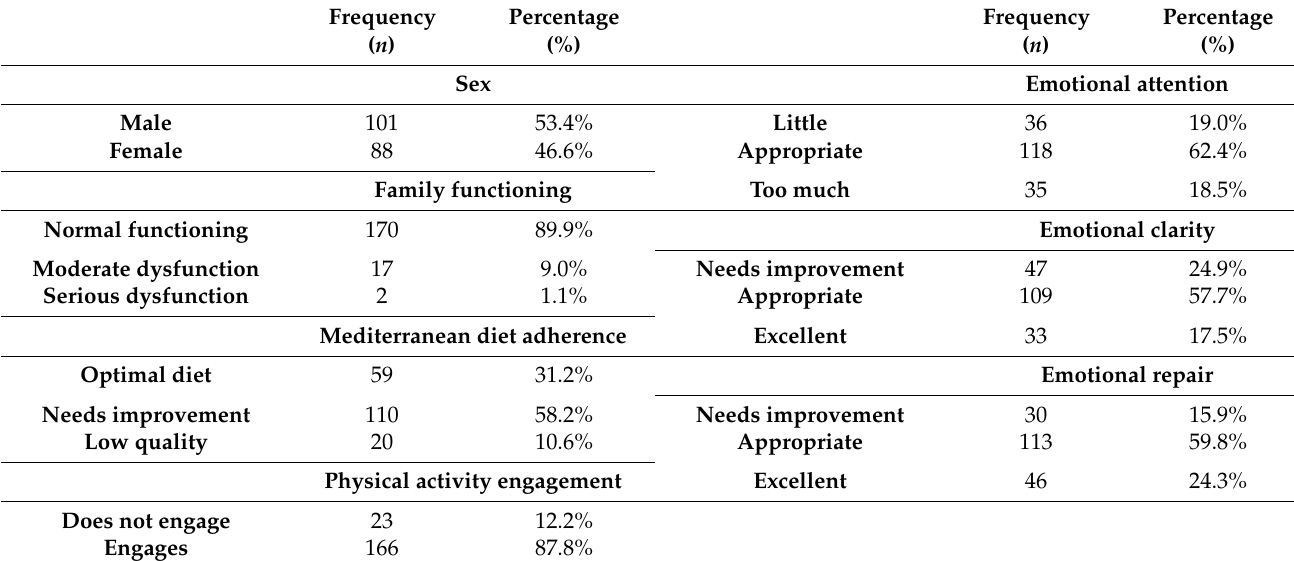
Table 1. Basic descriptive frequencies of the